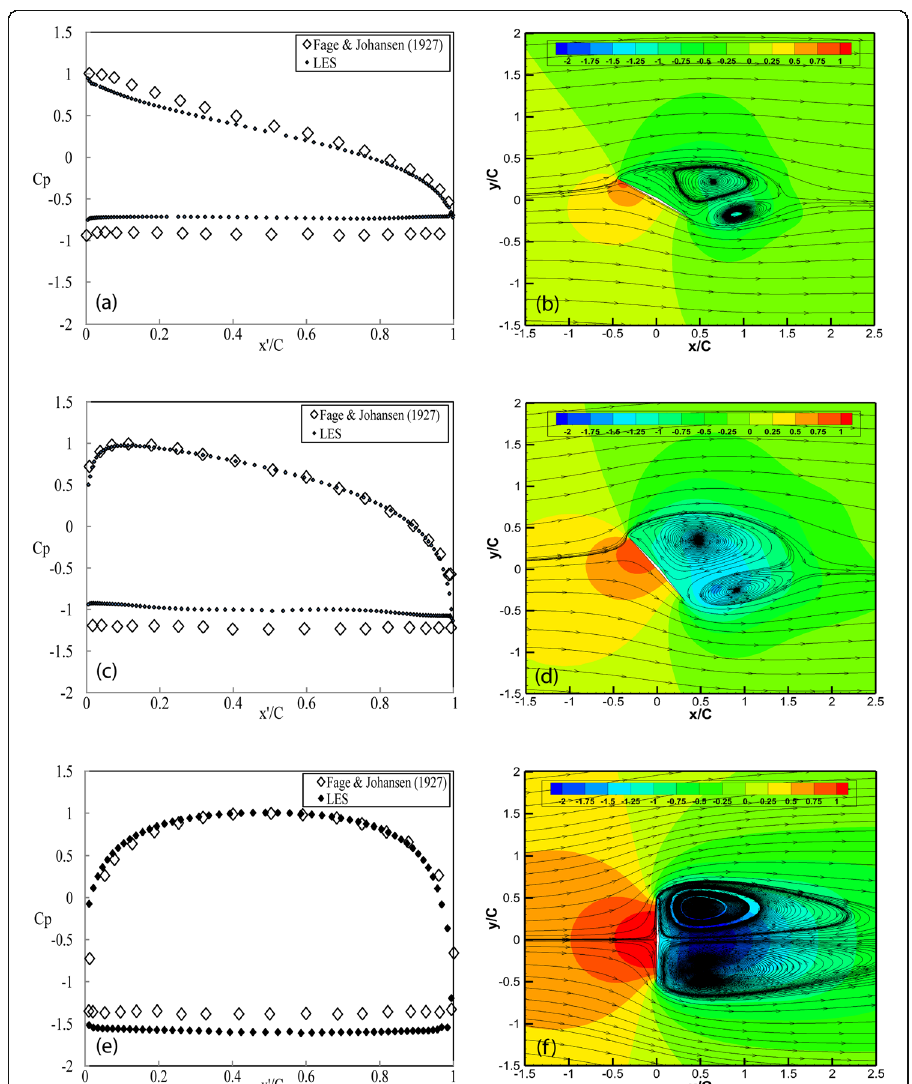
Fig. 3 Mean pressure coefficients and sectional streamlines at the mid-span a , b ) α = 30°, c , d ) α = 50° and e , f ) α = 90° (x ’ is the chordwise distance and x is the global x